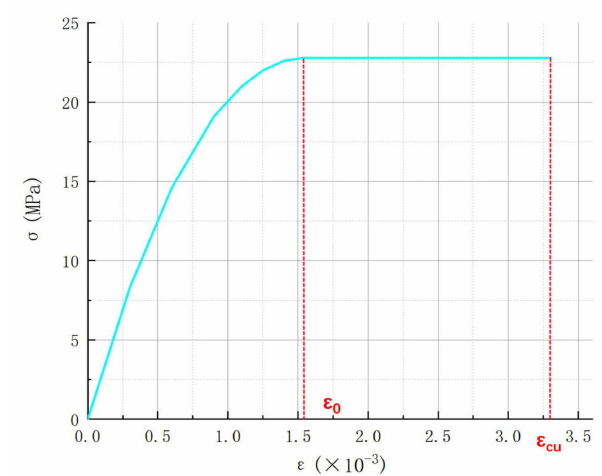
Figure 11. Constitutive relation of